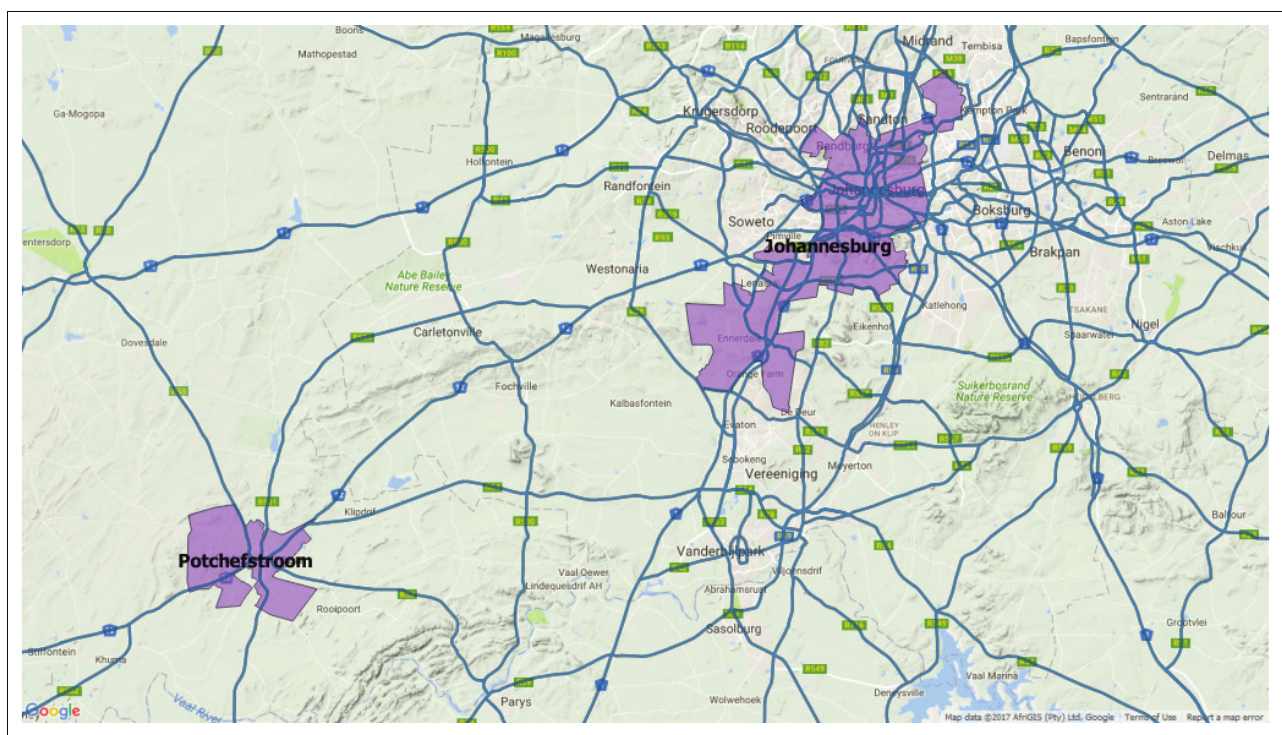
FIGURE 1: The study area,